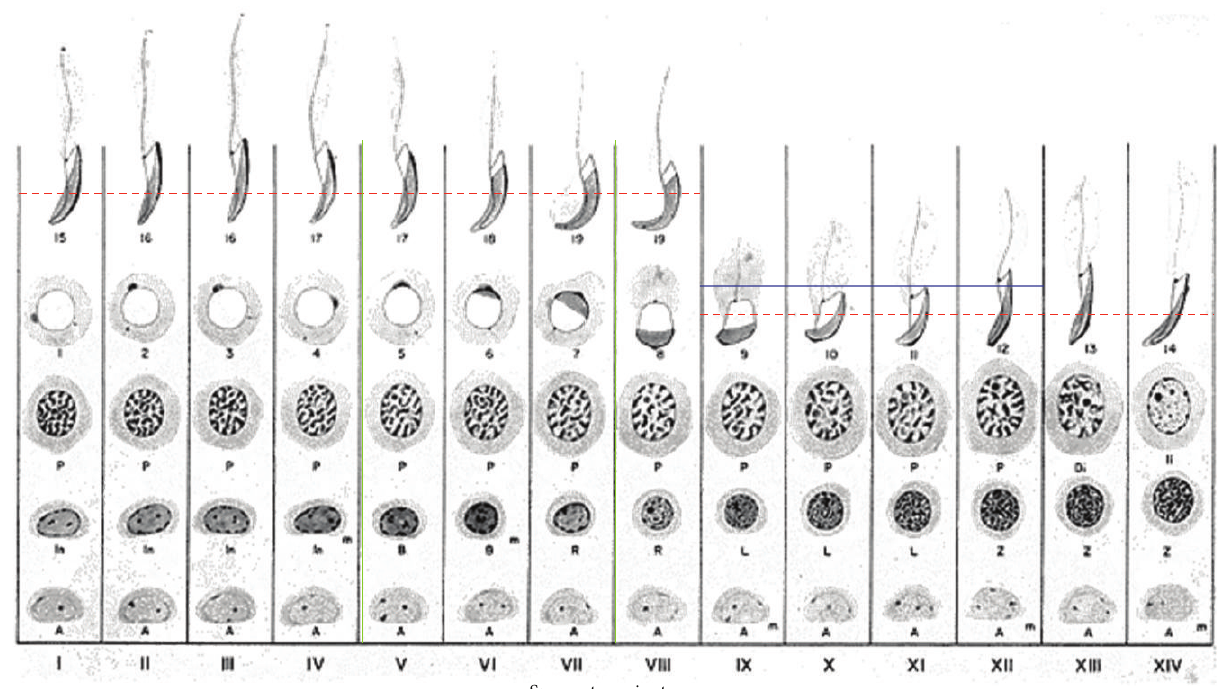
Figure 4: Schematic representation of Gnrh1 and Gnrhr1 expression in the germinal epithelium during a complete spermatogenetic cycle (modified from [45]). Columns show the sequence of germ cell generations observed in rat seminiferous tubule at that stage (I–XIV Stages). Spermatogonia: A (type A), In (intermediate), B (type B), R (resting, final DNA replication), and m (mitosis of spermatogonia). Primary spermatocytes: L (leptotene), Z (zygotene), P (pachytene), Di (diakinesis), and II (secondary spermatocytes). Phases 1–19 indicate spermatids differentiation(spermiogenesis).Horizontallinesindicatelocalizationwindowof Gnrh1 and Gnrhr1, bluelineandreddottedline,respectively. Vertical green lines indicate the expression window of Gnrh1 in Sertoli